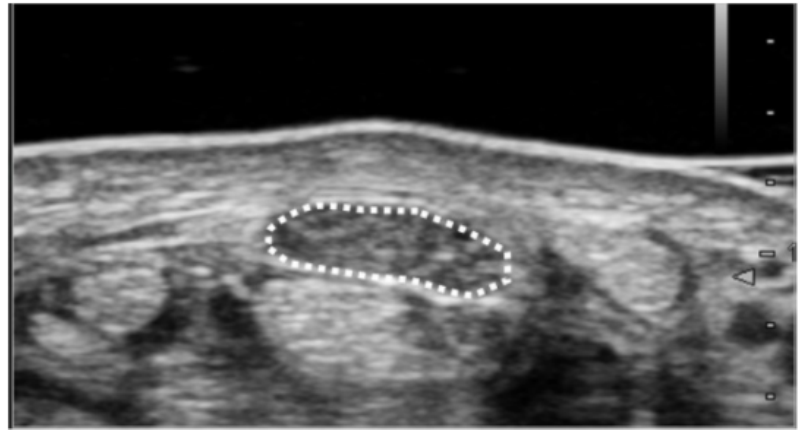
Figure 1. Ultrasound measurement of median nerve cross-sectional area. Cross-sectional area was measured as the only parameter for the image analysis. Measurement of the median nerve cross- sectional area was performed at the wrist crease level. The median nerve was outlined, and its area was calculated.